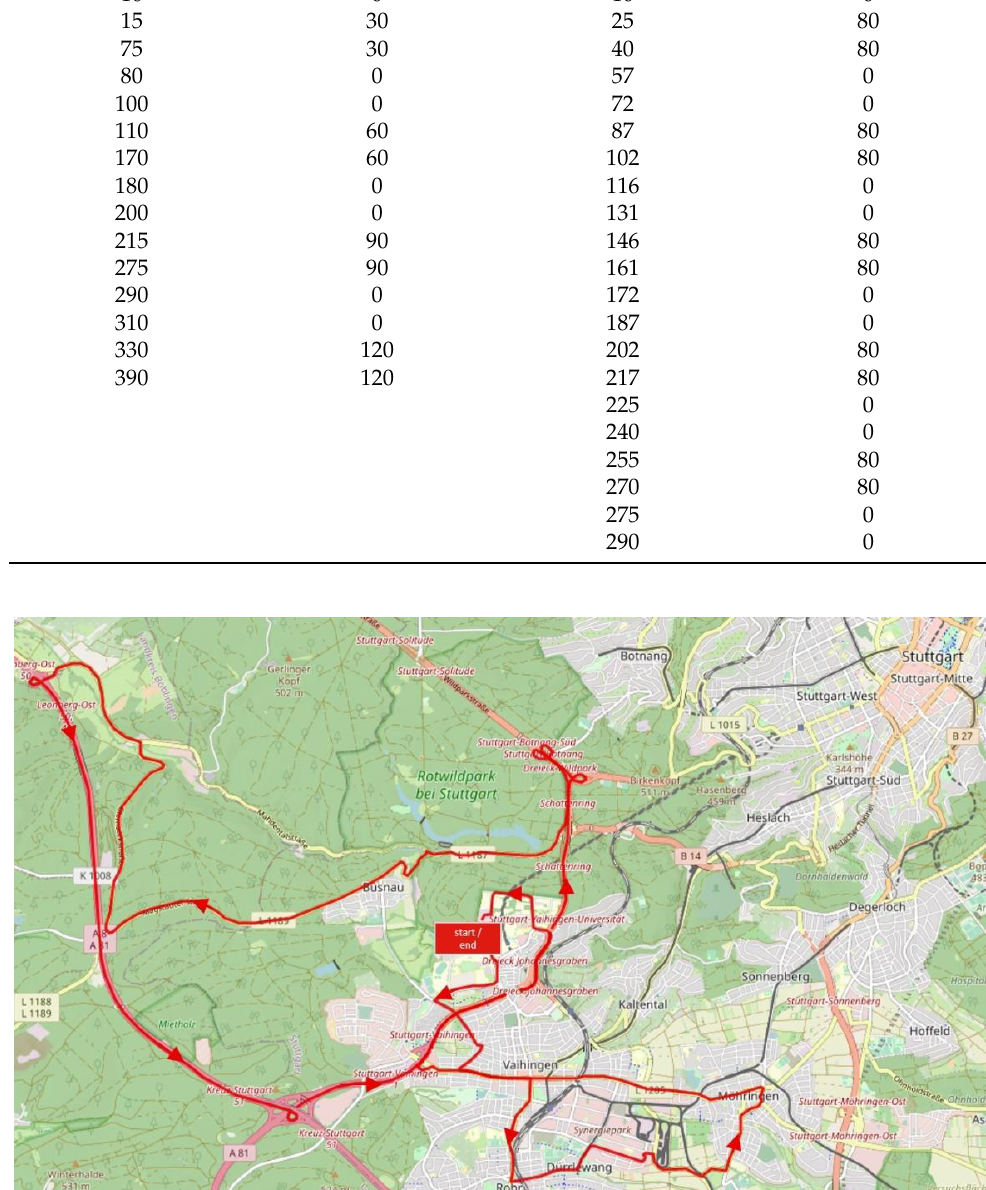
Table A1. Driving cycles for characterization of non-exhaust emissions.